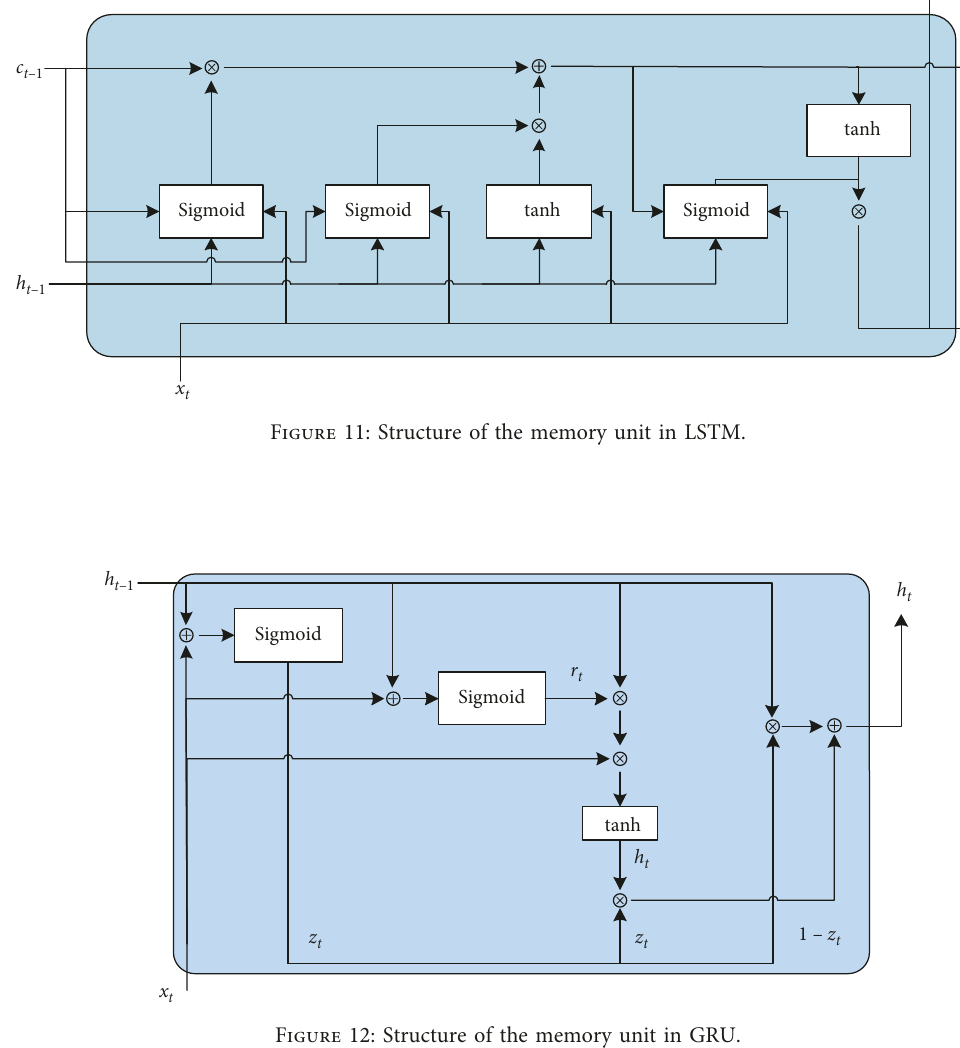
Figure 12: Structure of the memory unit in GRU.